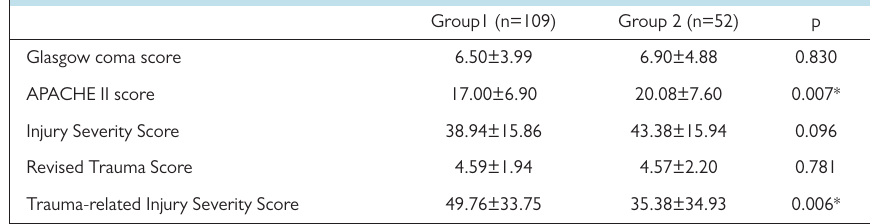
Table 2. Comparison of groups in terms of trauma index scores